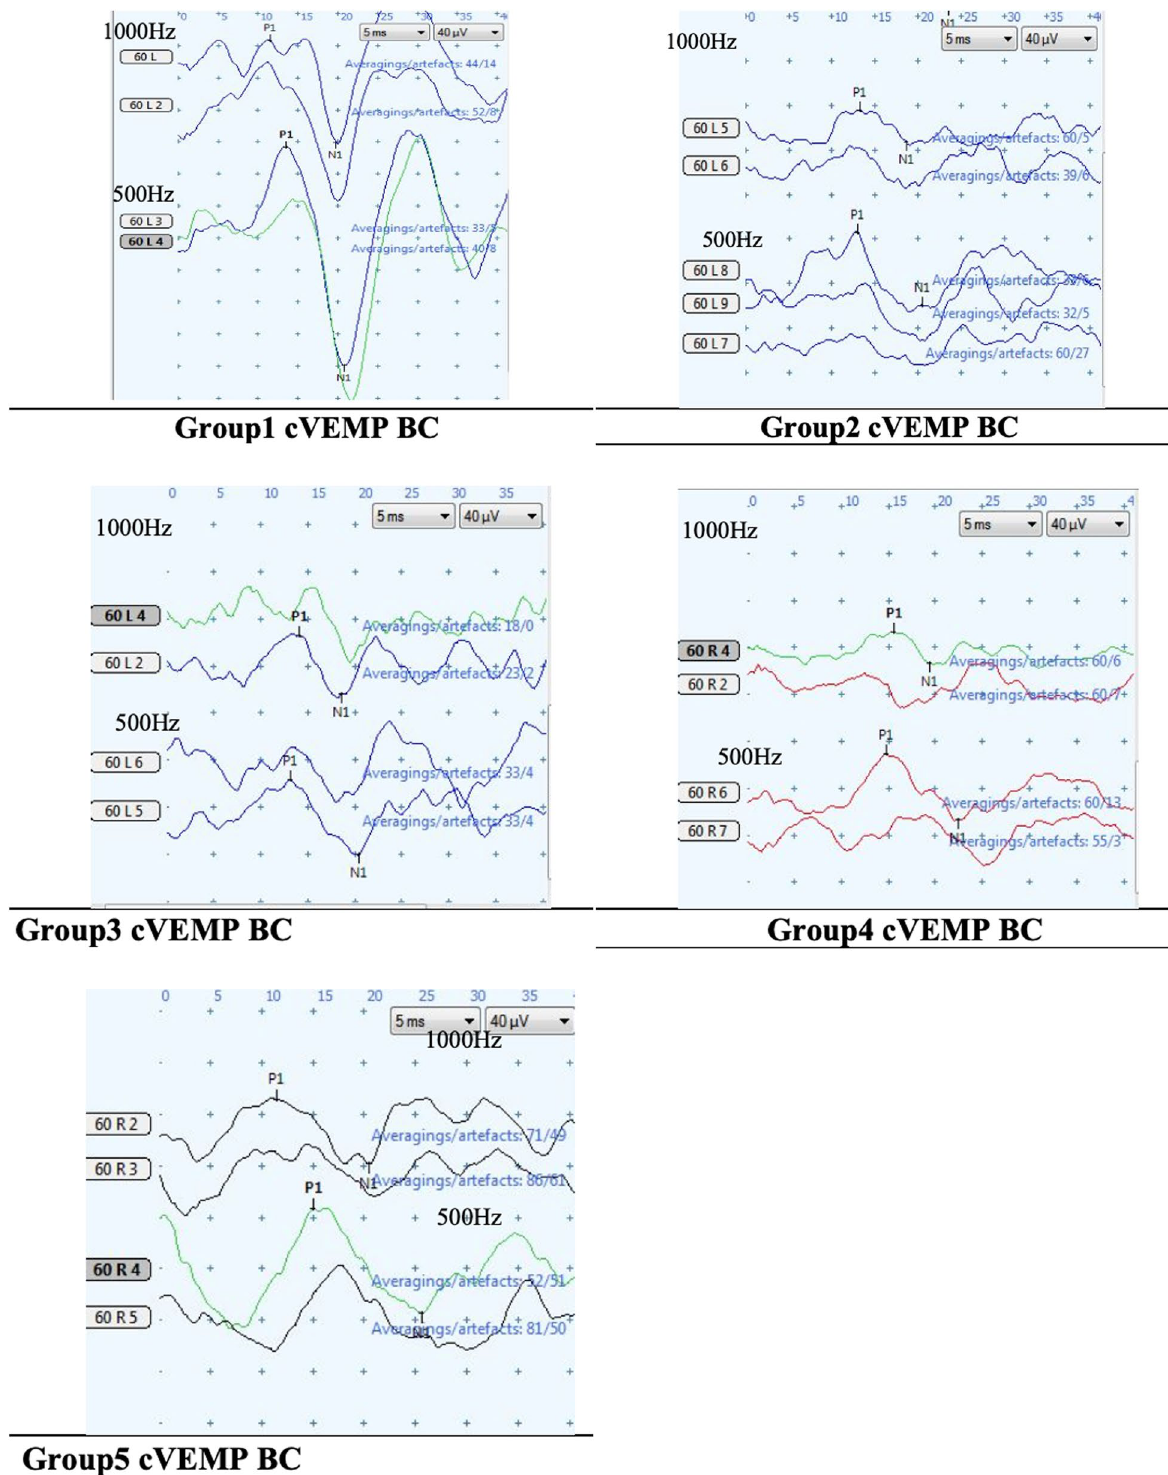
Fig. 2 cVEMP bone conduction (BC) traces at 1000 Hz and 500 Hz in the 5 age groups. In group 5, only 5/16 subjects were above 70 years. The distribution of cVEMP response above 70 years is shown in Fig.